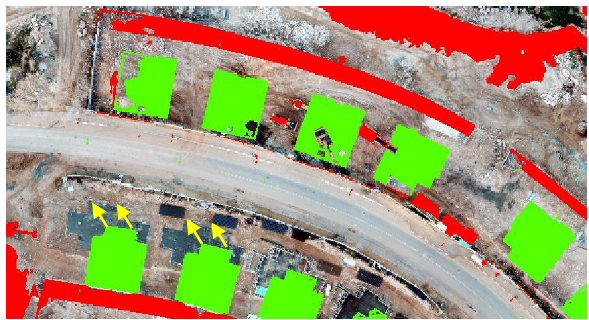
Figure 2. Example of the calculation of height difference performed without spatial adjustment: areas are wrongly classified as a change in the area (red and green).